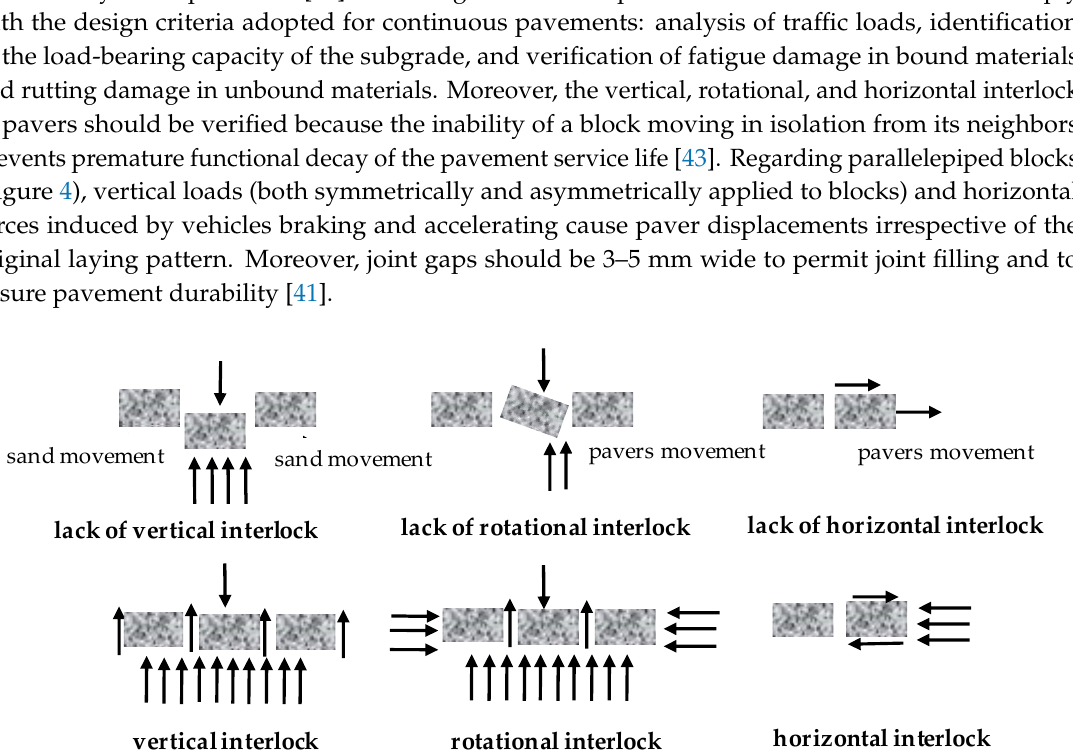
Figure 4. Block Figure 4. Block interlock.